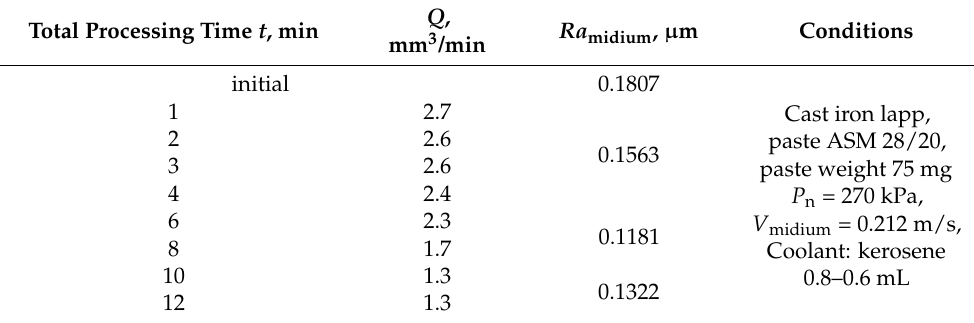
Table 5. The effect of processing time on the productivity and roughness of the lapped surface. Q Total Processing Time t , min